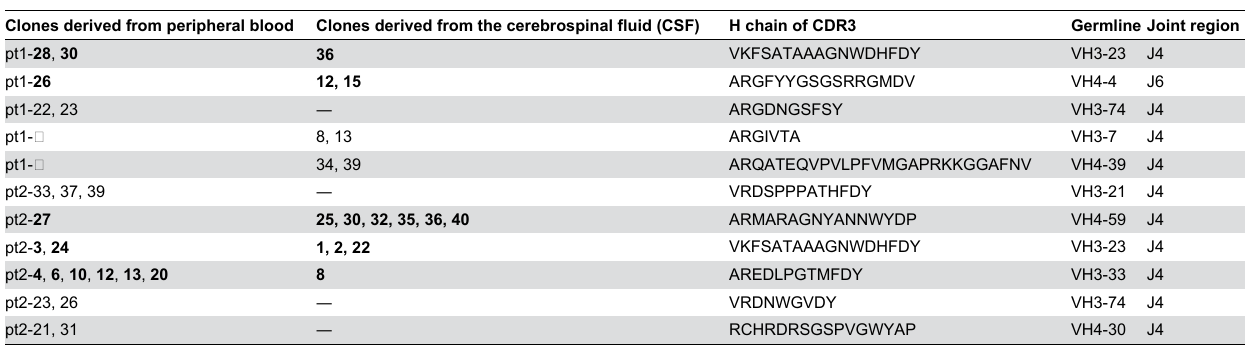
Clones derived from peripheral blood Clones derived from the cerebrospinal fluid